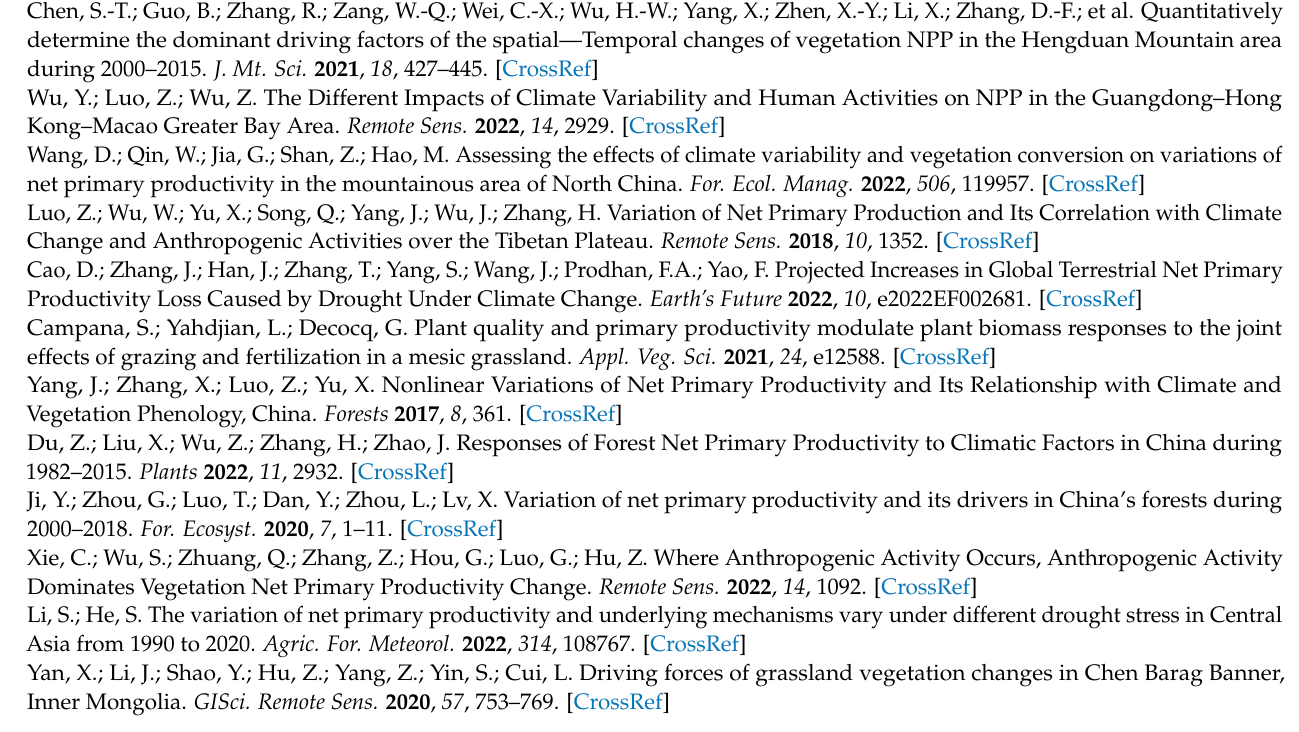
Schematic diagram of interaction detection. Figure S2: